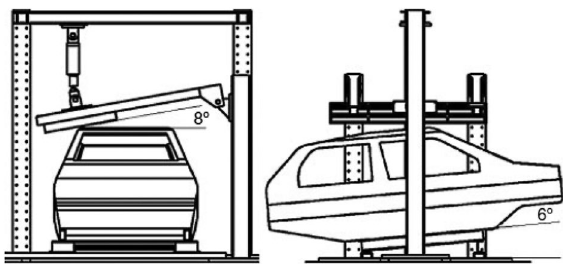
Fig. 3. Roof crush test set-up (Chen et al. 2007)